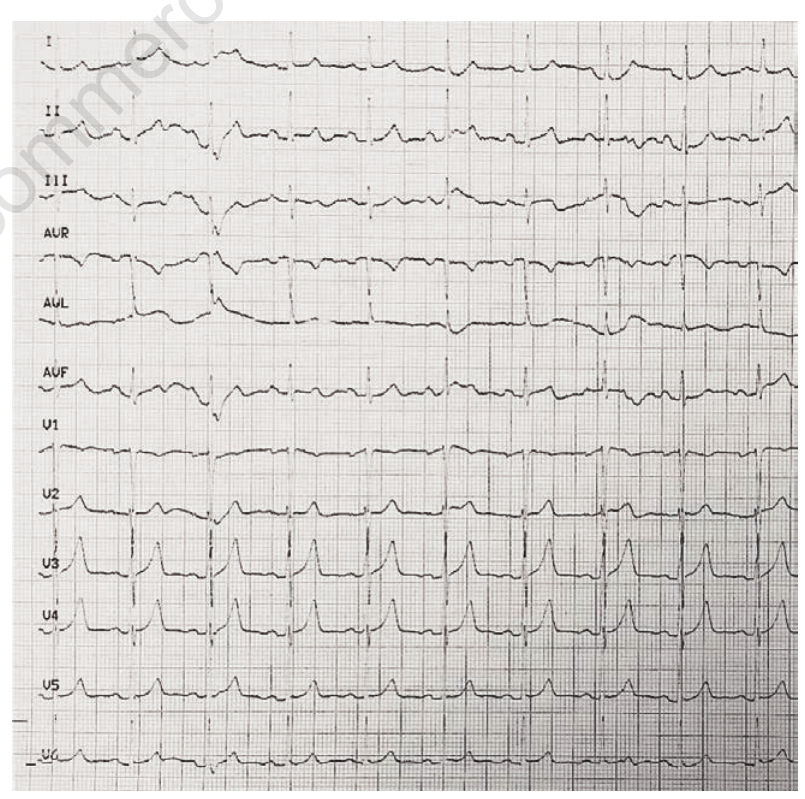
Figure 2. ECG after electrical cardioversion. The patient returned to sinus rhythm. QTc interval 423 ms (Bazett’s